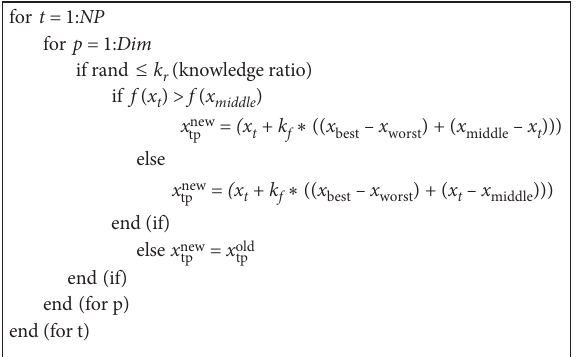
Figure 6: Pseudocode for senior gaining-sharing knowledge stage. Note: p ∈ [ 0 , 1 ] is the percentage of best and worst